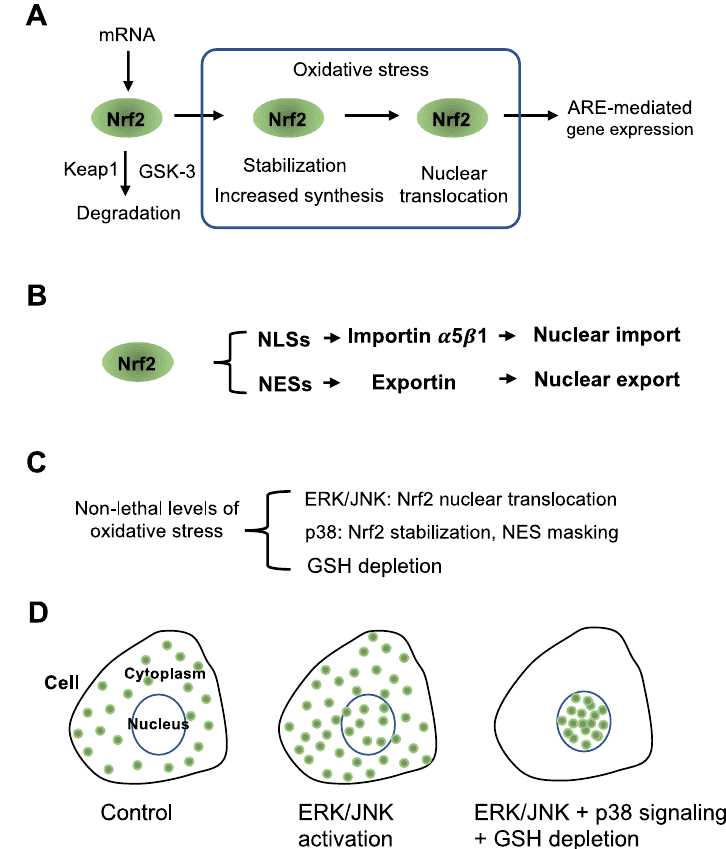
Figure 1. MAP kinases p38, ERK, JNK, and GSH depletion control activation of the transcription factor Nrf2. ( A ) Rapid activation of Nrf2 under oxidative stress depends on two separate steps, stabilization and upregulation of Nrf2 protein and nuclear translocation. ( B ) Nuclear import of Nrf2 is controlled by the association of importin α 5 β 1 to its nuclear localization signals (NLSs), while nuclear export of Nrf2 is controlled by exportin binding to its nuclear export signals (NESs). ( C ) Non-lethal levels of oxidative stress, such as H 2 O 2, induce GSH depletion and activation of MAP kinases (reviewed in [1]). ERK and JNK control Nrf2 nuclear translocation, and p38 signaling induces stabilization of Nrf2 and masking of an NES. ( D ) In unstressed conditions, Nrf2 (green dots) levels are low and mainly localized in the cytoplasm but not in the nucleus due to functional nuclear export signals. ERK/JNK activation could cause nuclear transport of Nrf2 across the nuclear membrane but does not enable Nrf2 to accumulate in the nucleus due to the functional nuclear export signals. As p38 signaling masks a nuclear export signal, simultaneous activation of ERK and p38 signaling pathways under GSH-depleting conditions induces effective nuclear accumulation/activation of Nrf2.